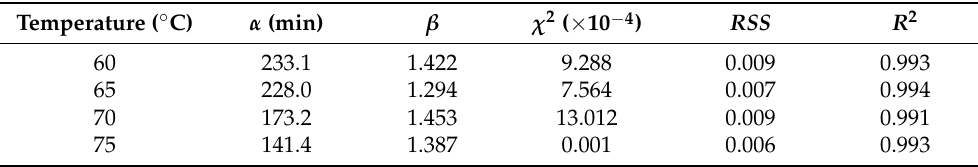
Table 1. Regression results of Weibull model fitted to moisture ratio changes at different drying temperatures during